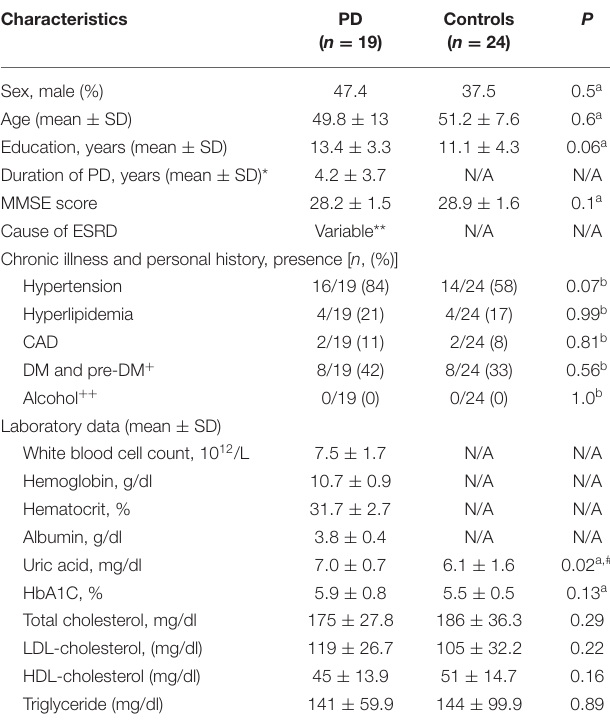
TABLE 1 | Demographic characteristics of